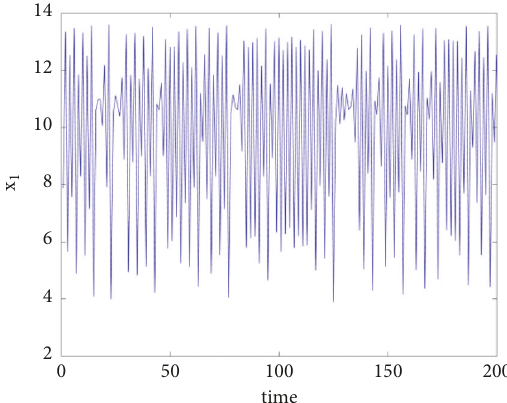
Figure 10: The time series plot with parameters 𝑎 = 7.12 , 𝑏 = 0.024 , 𝑐 = 0.98 , 𝛽 = 0.38 , 𝛾 = 0.44 , and 𝛼